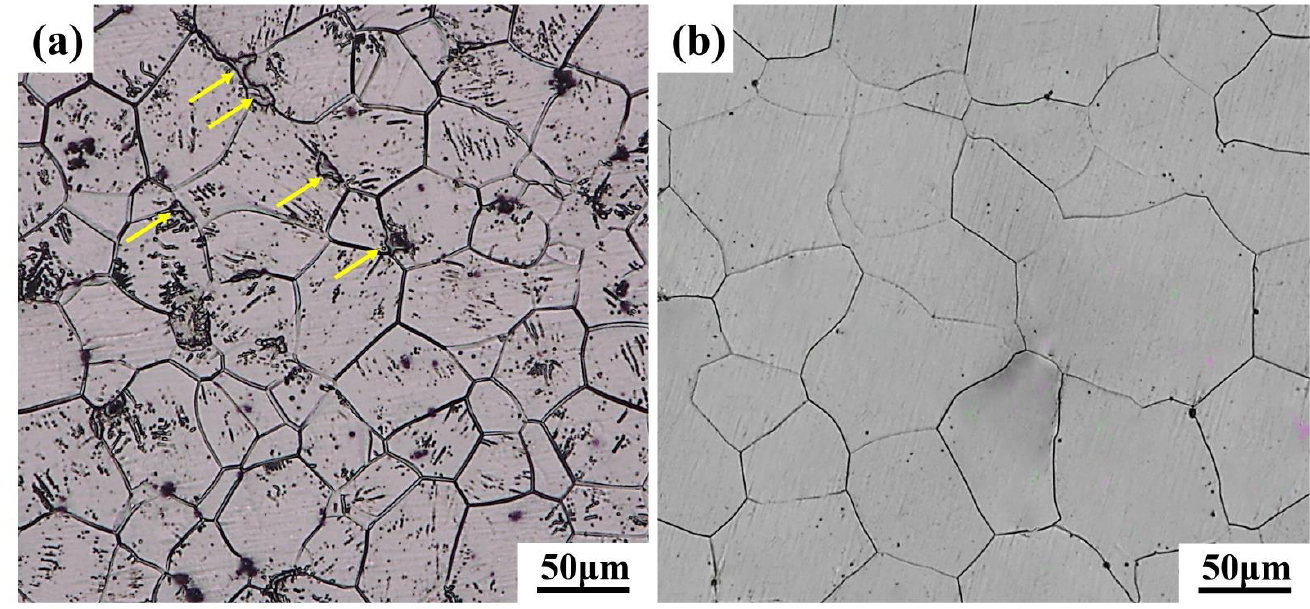
Figure 2. Microstructures of ( a ) as-cast and ( b ) as-solutioned GW94K magnesium alloy.